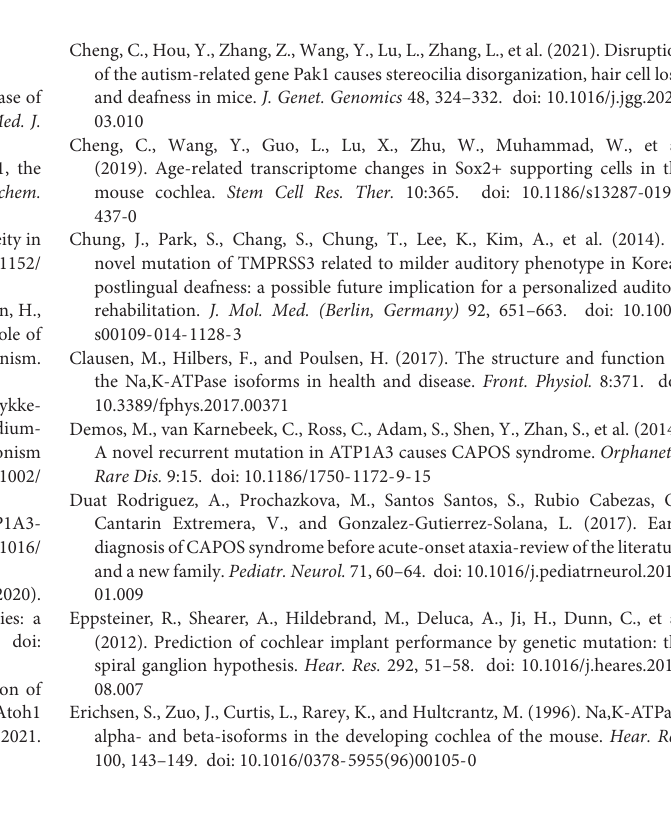
Supplementary Figure 1 | Audiological phenotype of subject 3 and 4. (A,B) PTA of subjects 3 and 4. Blue, left ear; red, right ear. (C,D) Observed DPOAE responses from the right and the left ear. Red line, DPOAE level from the right ear; blue line, DPOAE level from the left ear; gray line, noise level from both ears. (E,F) Absent ABR waveforms at 90 dB nHL stimulus on both ears of subjects 3 and 4. Blue, left ear; red, right ear. Supplementary Table 1 | ATP1A3 genotypes as they correlate with RDP, AHC, and CAPOS phenotypes. Supplementary Table 2 | Postsynaptic auditory neuropathies and their CI